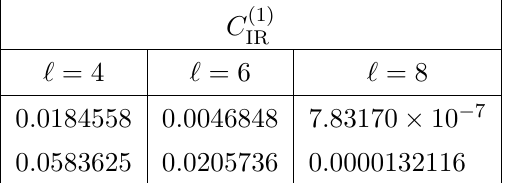
found for several values of ‘ . All values IR